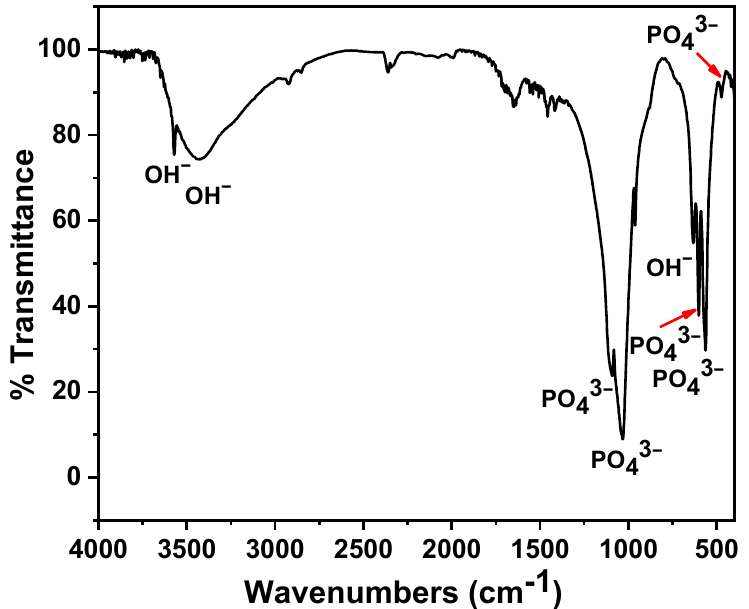
Figure 2. Fourier transforms infrared (FTIR) spectrum of nano-hydroxyapatite (n-HAP).